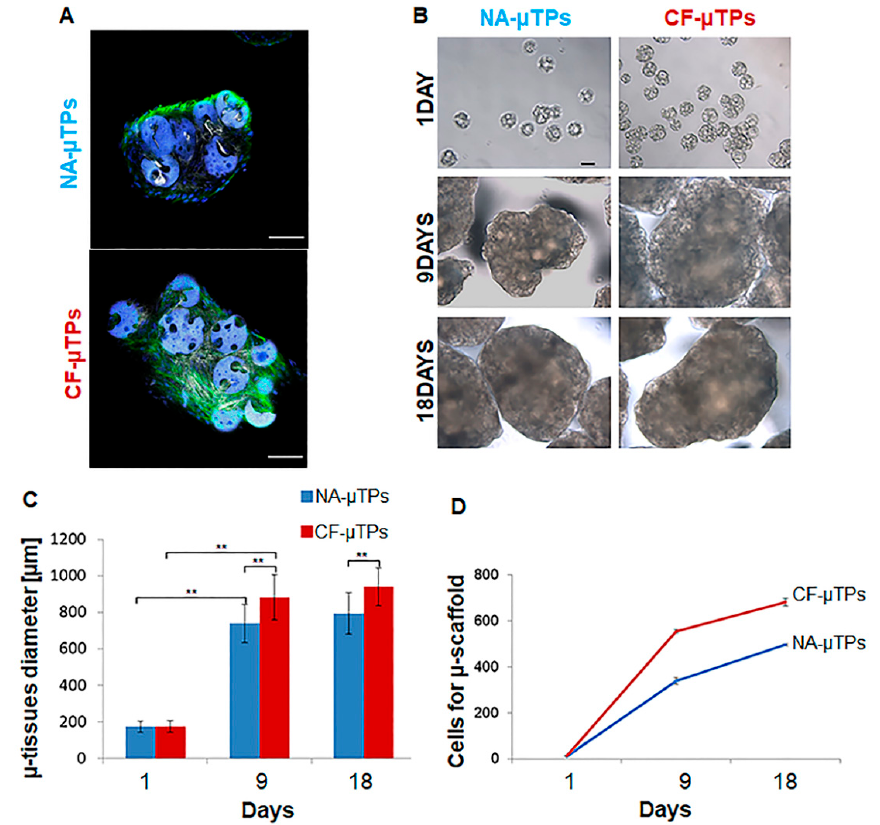
Figure 2. µTPs morphological characterization. ( A ) Representative images of normal and cystic fibrosis micro-tissues (NA-µTPs and CF-µTPs) showing the nuclei of the cells marked in blue by DAPI, the actin cytoskeleton in green by 488-Phalloidin and the collagen in gray by second harmonic generation signal (SHG), scale bar 100 µm; ( B ) optical microscope images of NA-µTPs and CF-µTPs 1, 9, and 18 days after the seeding of the fibroblasts on the micro-scaffolds, scale bar 100 µm; ( C ) Histogram of NA-µTPs (blue) and CF-µTPs diameter (red) over time (** p value <0.01), data are showed as Mean ± Standard Deviation; ( D ) Graphic showing the number of cells per micro-scaffold over time in n NA-µTPs (blue) and CF-µTPs (red). Table 3. Correlation length analysis.